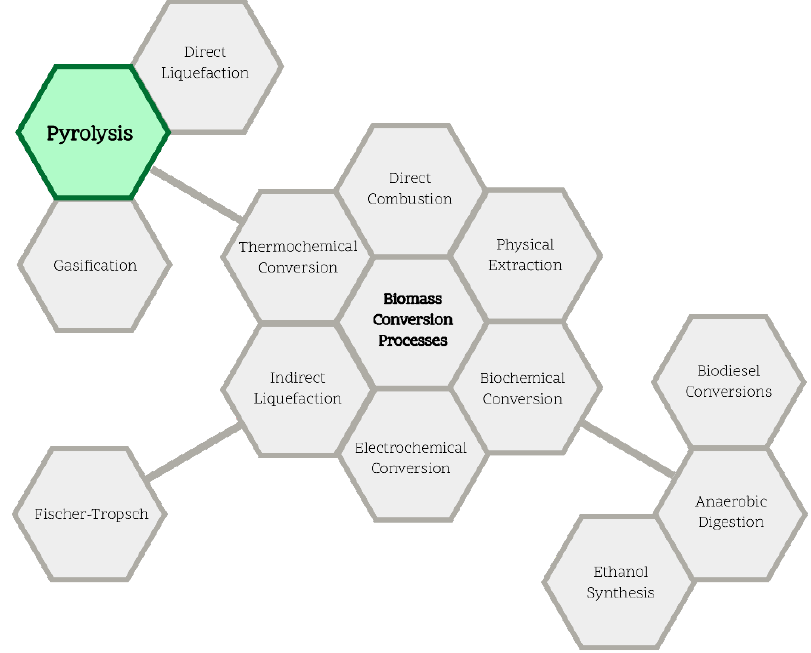
Figure 1. Main methods for biomass conversion. Based on Lin and Waters 2015 [3].